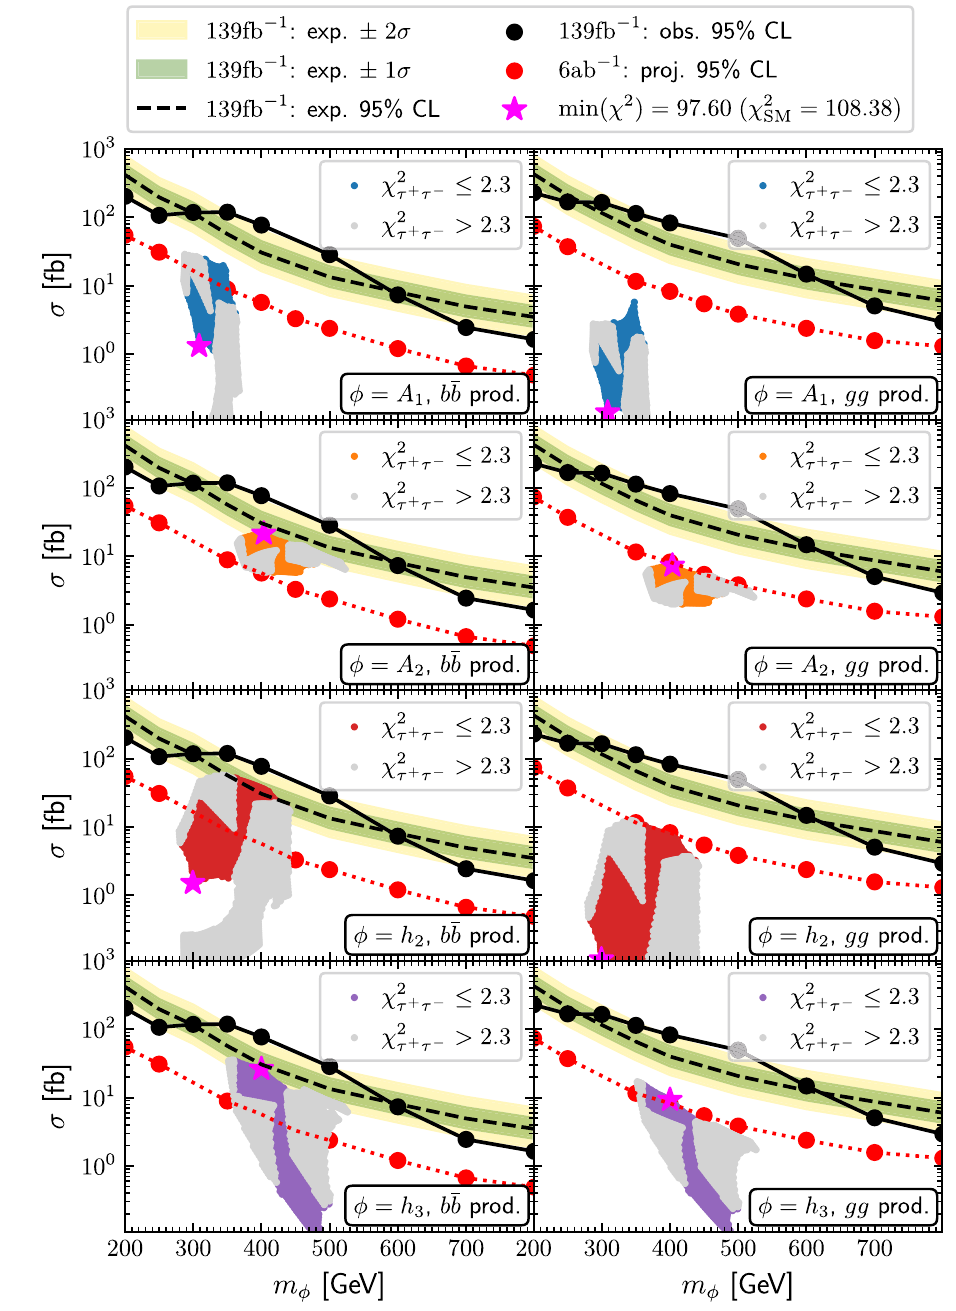
Fig. 17 NMSSM parameter points of the scan with tan β = 8 . 0 (see Table 4) with m φ on the horizontal axis and σ( b ¯ b → φ → τ + τ − ) (left) and σ( gg → φ → τ + τ − ) (right) on the vertical axis, where φ = A , A , h 1 2 2 and h 3 in the first, second, third and fourth row, respectively. The colors of the points indicate whether the parameter point lies inside (colored) or outside (gray) of the 1 σ ellipse regarding χ 2 τ + τ − . The best fit values are highlighted with a magenta star. The current expected and observed limit [7] as well as a projection for the expected HL-LHC exclusion limits [66] are also